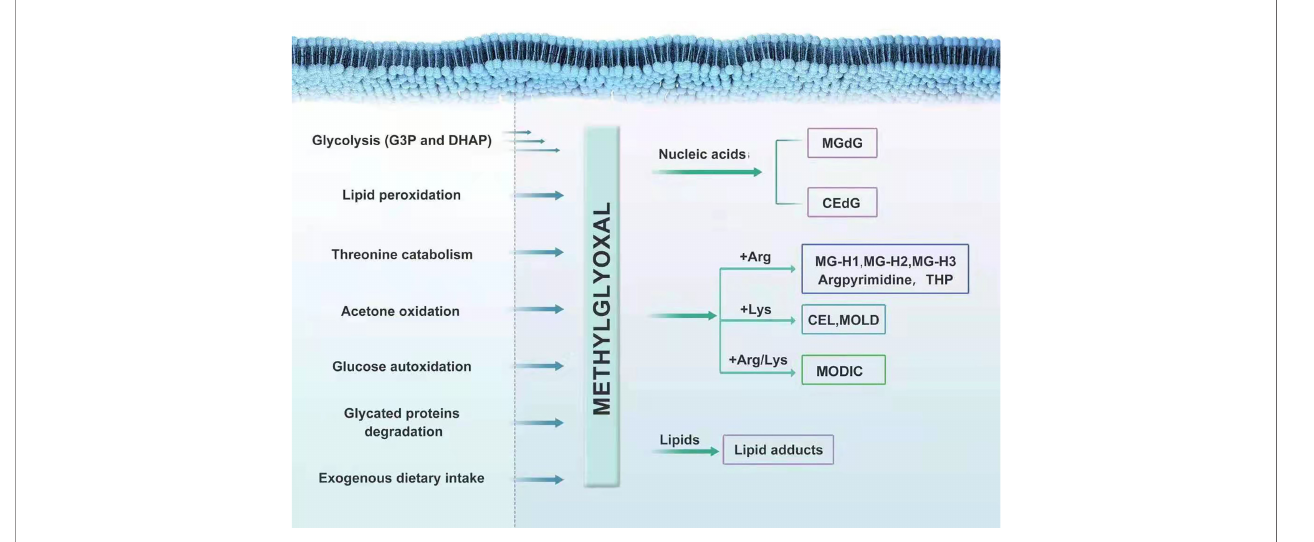
FIGURE 1 | The formation and metabolism of